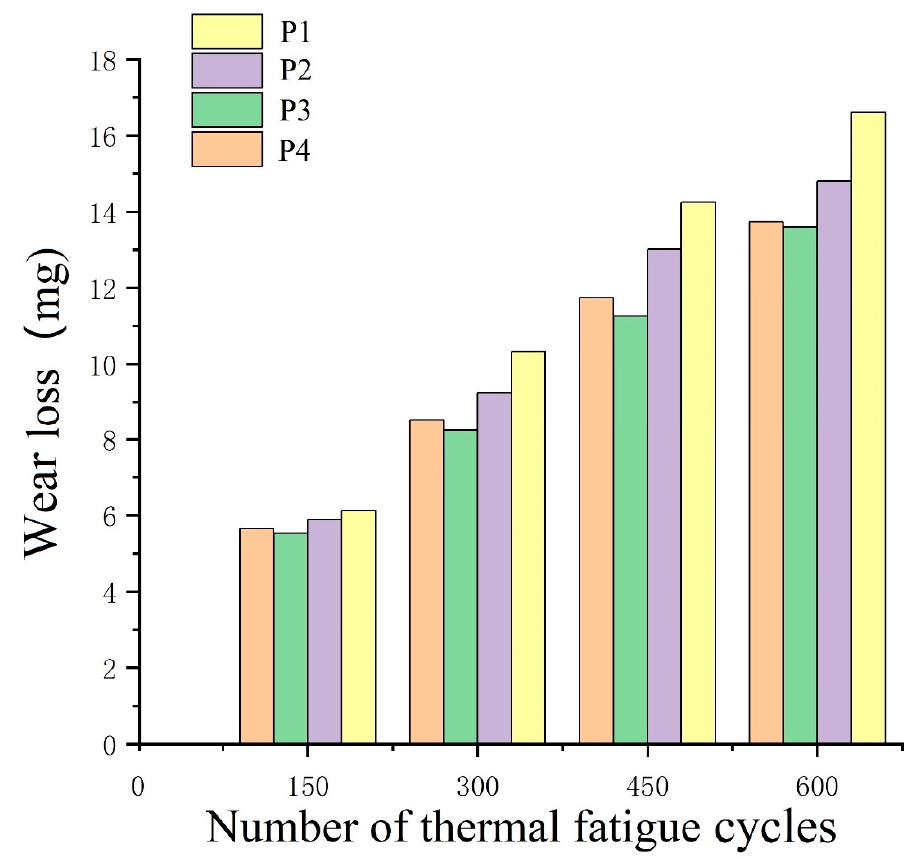
Figure 17. Weight loss results of thee bionic samples in the wear test with semi-metallic brake pads after thermal cycling.